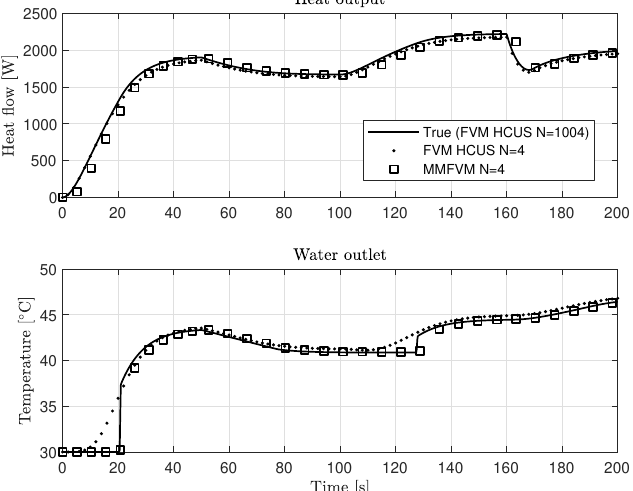
Figure 6. Time evolution of the heat output Q and the water outlet temperature T w,out (at x =